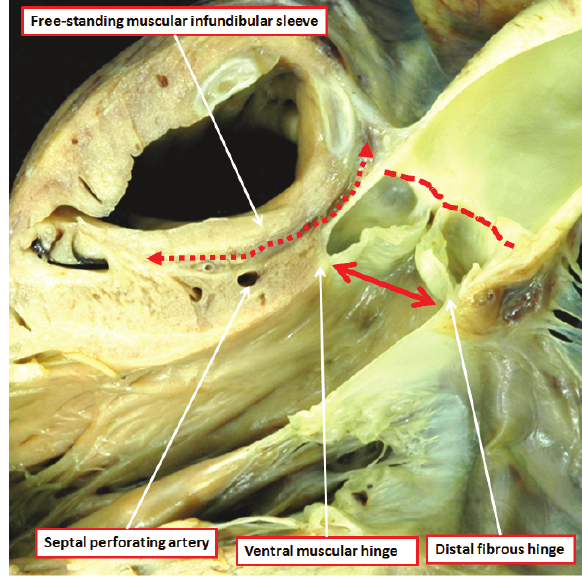
Figure 5. The dissection of a postnatal human heart shows how an extracavitary tissue plane (double headed red dashed arrow) interposes between the free-standing infundibular sleeve of the right ventricle and the aortic root. Note also the sinutubular junction (red dashed line) and the virtual echocardiographic annulus (solid double headed red arrow) of the aortic root. The ventral leaflets of the aortic valve have muscular basal hinges, whereas the hinge of the non-adjacent leaflet is in fibrous continuity with the mitral